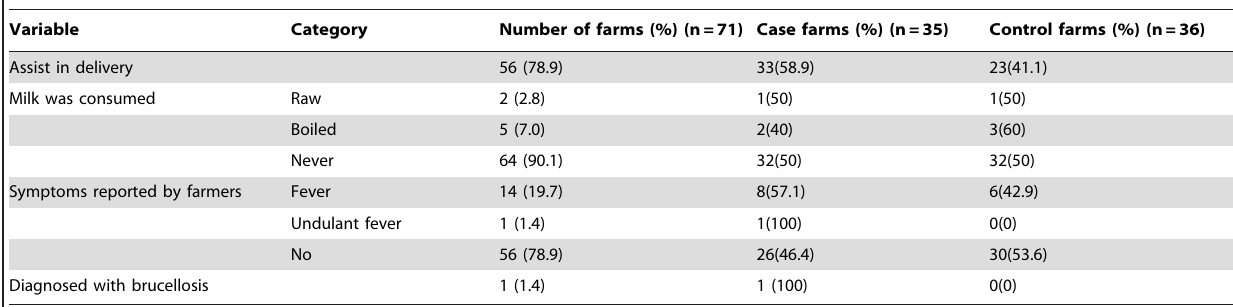
Table 3. Potential risk of Brucella infection among cattle